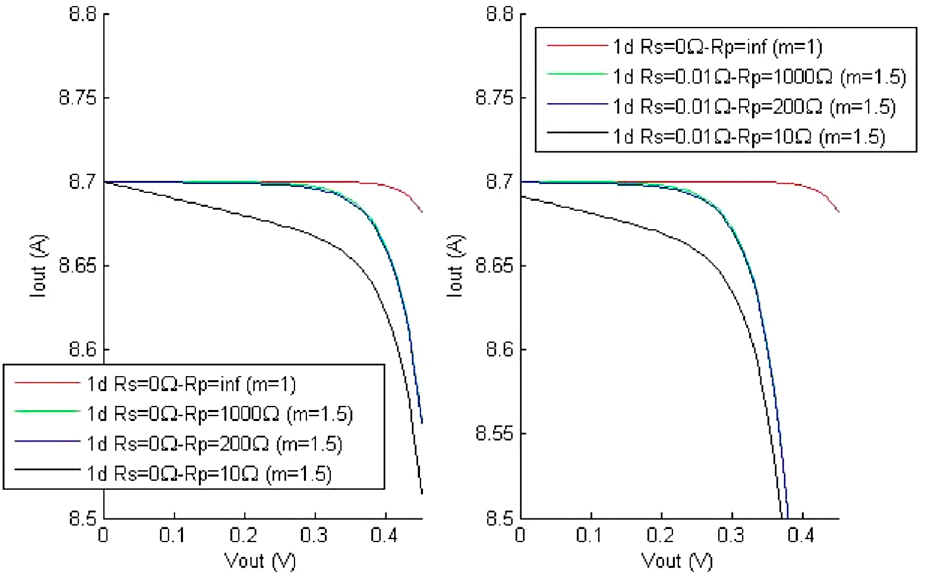
Energies 2018 , 11 , x FOR PEER REVIEW Figure 3. Extended I - V characteristic curves. Figure 3. Extended I - V characteristic curves.